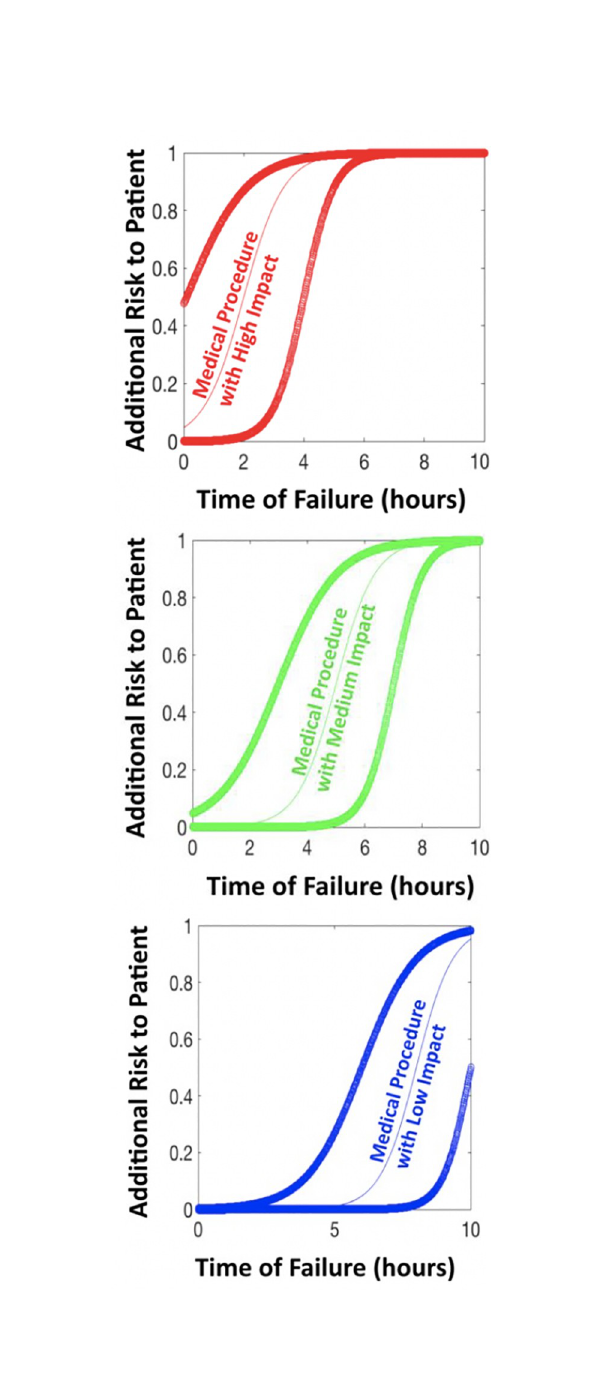
Fig 3. The y-axis shows additional risk to patient as a result of starting a medical procedure which required an electrically powered medical device. The duration of the electricity failure increases the patient risk, which is on the x- axis. Medical procedures can be placed into four categories of impact regions (high impact—top, medium impact— middle, and low impact—bottom) or no impact (not shown, but flat line on zero). These curves can also be easily adjusted with two parameters as data becomes